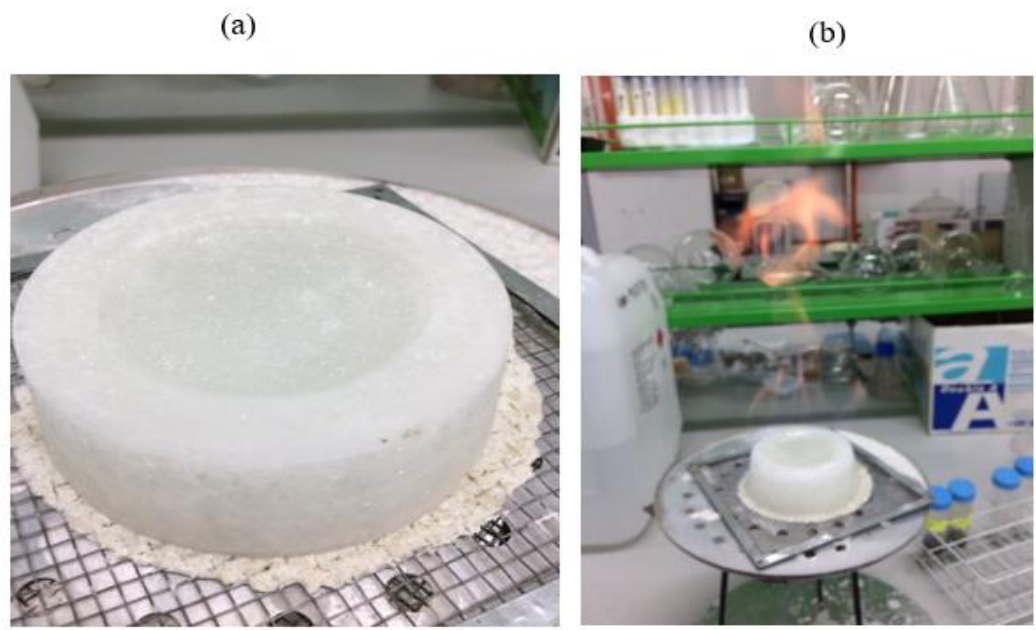
Figure 6. ( a ) Solid bioethanol after shaping. ( b ) Solid bioethanol burning.